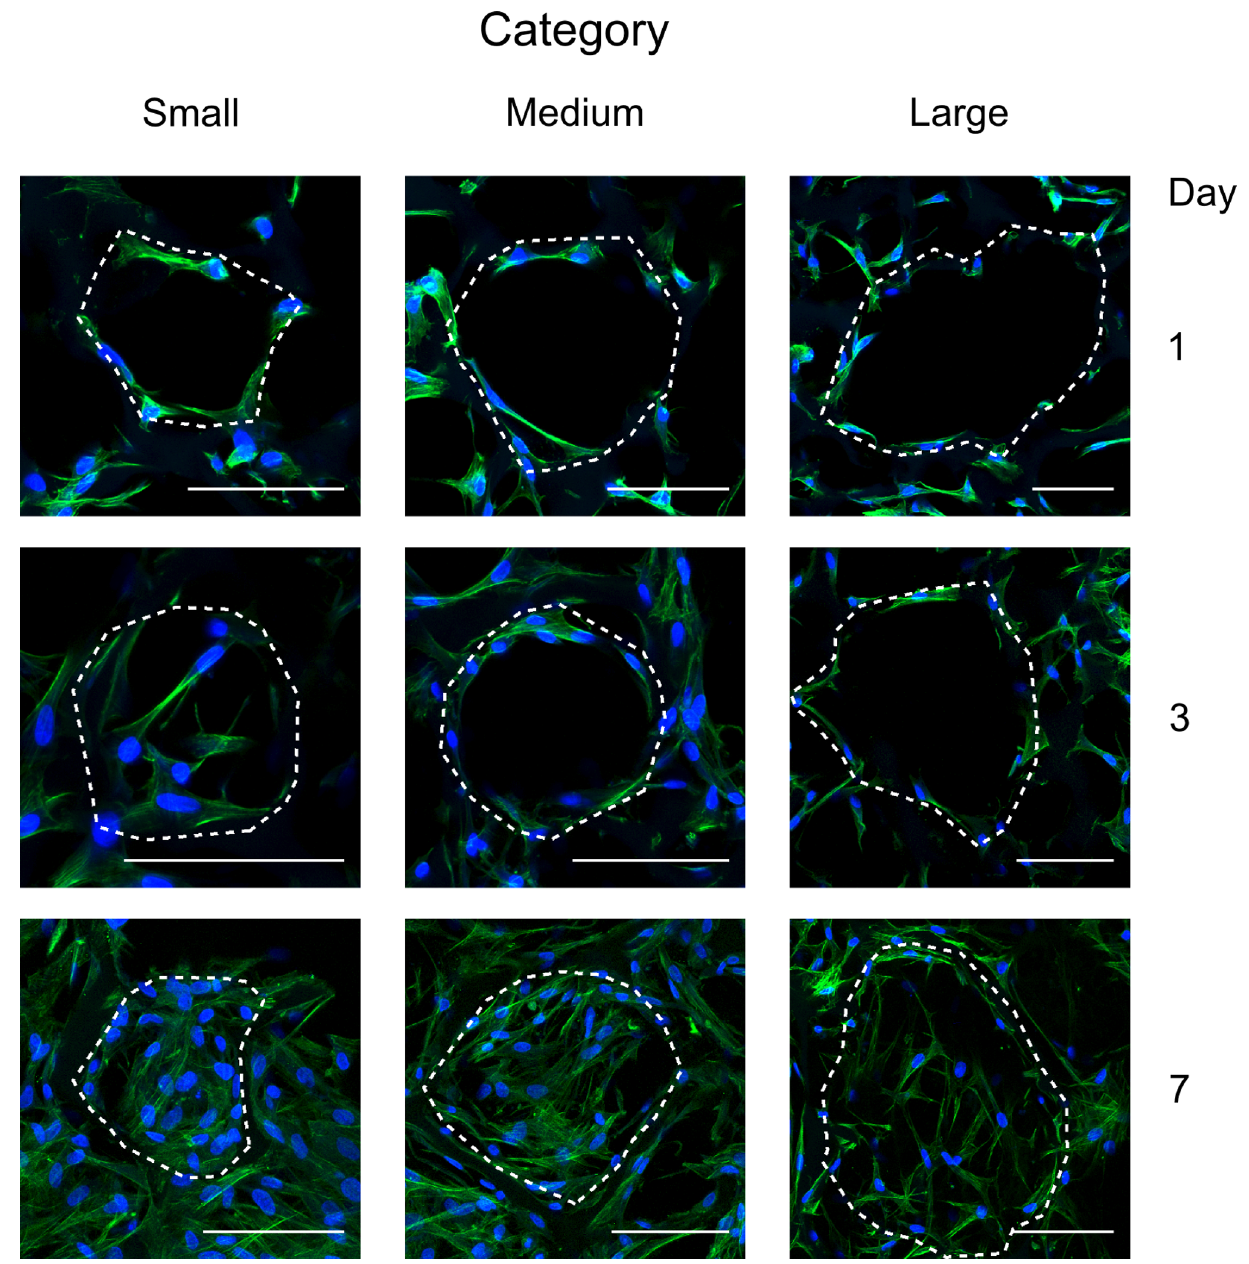
Figure 2. Filling of scaffold pores by fibroblasts for three pore size categories and three time points. Confocal microscopy for visualization of actin cytoskeleton (green) and cell nuclei (blue) to illustrate the filling of scaffold pores by human fibroblasts at day 1, 3, and 7 for the three pore size categories (scale bar equals 100 m m). Data shown corresponds to the maximum projection images of the 3D image stacks recorded inside scaffolds. During the imaging, scaffold pores could be identified due to background staining of the scaffold material and are highlighted by dashed lines.